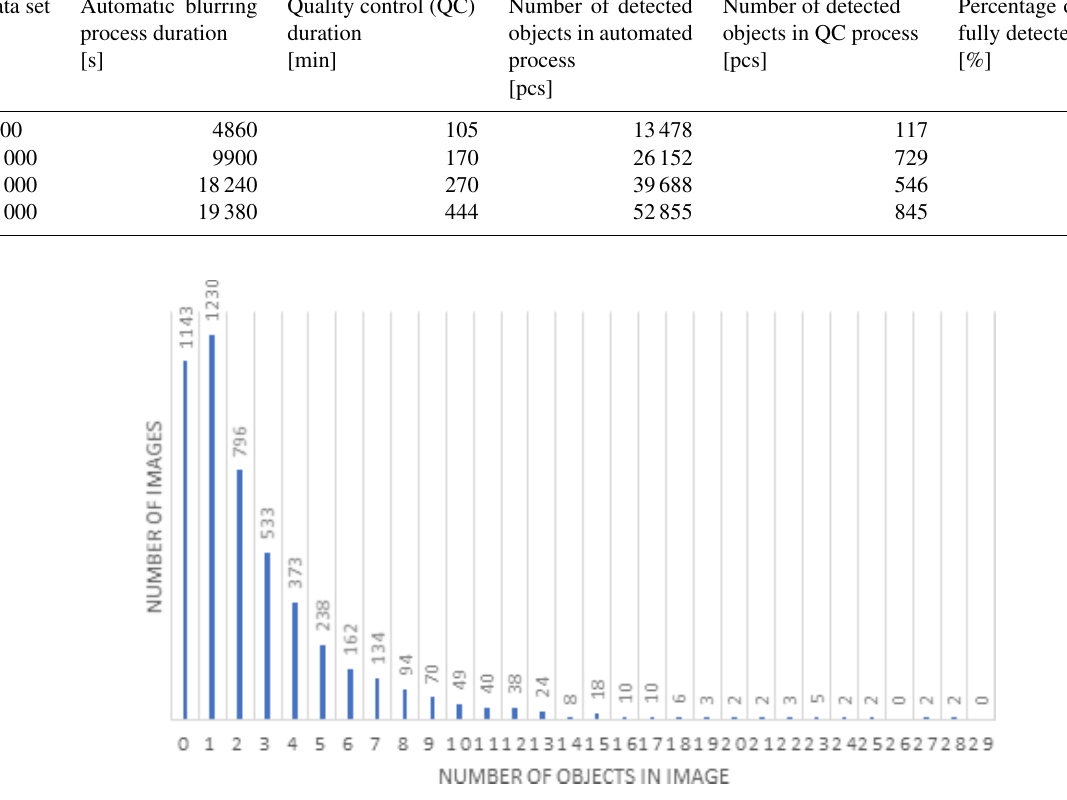
Figure 2. Average distribution of objects in images – data set with 5000